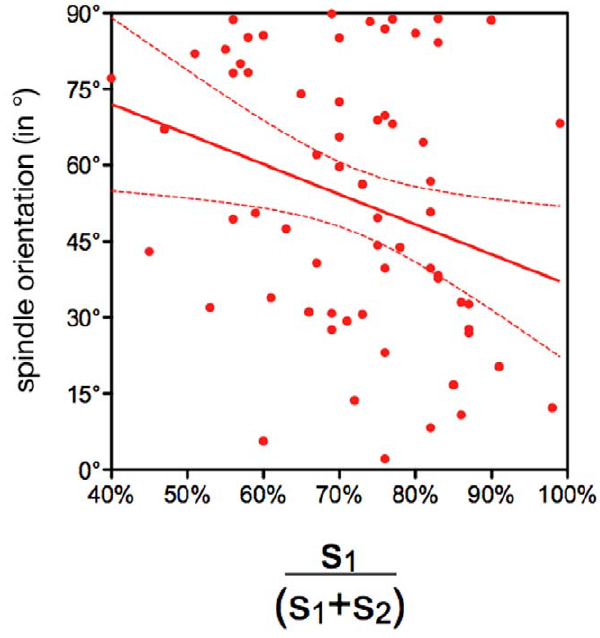
Figure 9. Blastomere bulging during mitosis influences spindle orientation. Correlation between spindle orientation (Y axis) and the